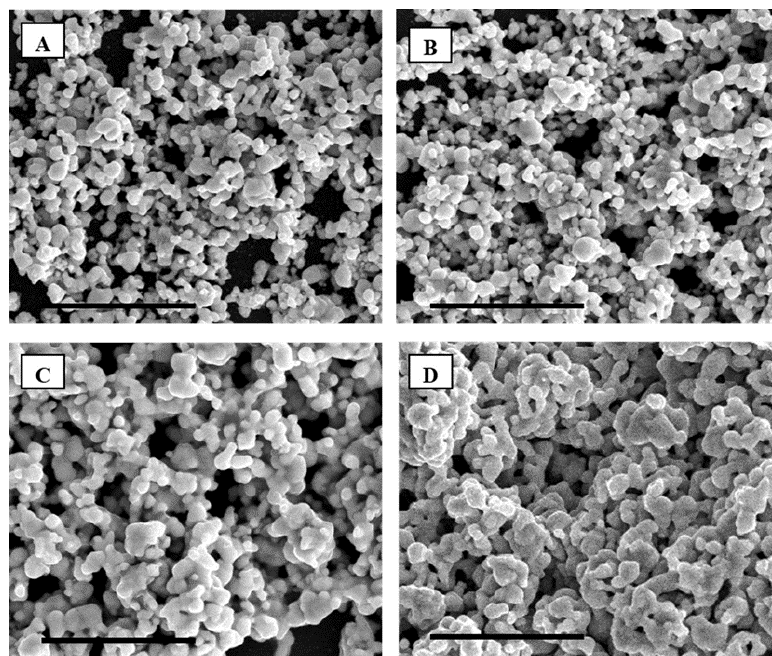
Figure 7. SEM of F127 in water with 15 wt % silver NPs spin-coated at respectively ( A ) 0, ( B ) 100, ( C ) 1000 and ( D ) 2000 rounds per minute (rpm) after annealing in air at 250 °C. The scale bar corresponds to 5